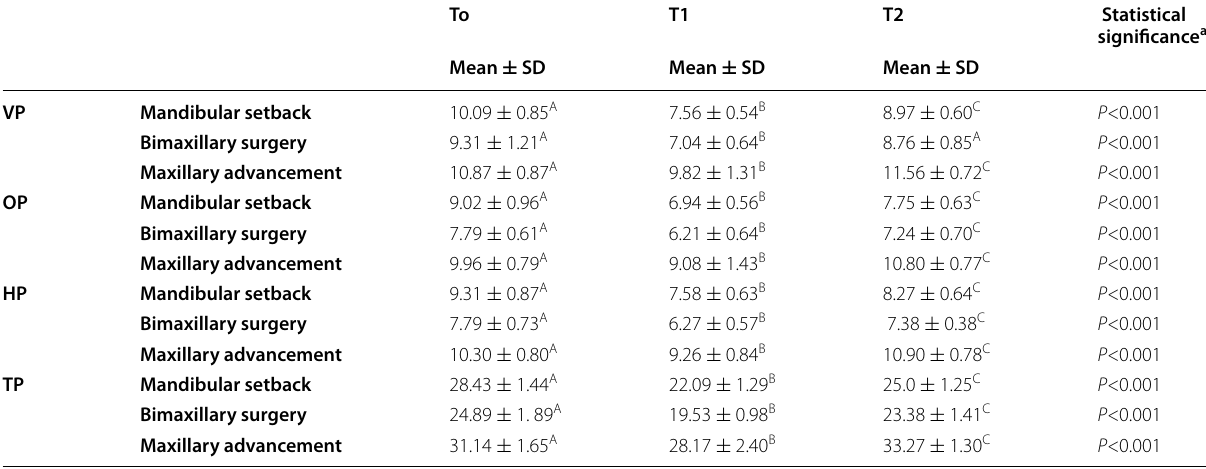
Table 2 The mean and standard deviation (SD) for velopharyngeal (VP), oropharyngeal (OP), hypopharyngeal (HP), and total pharyngeal (TP) dimensions in the study groups at different intervals